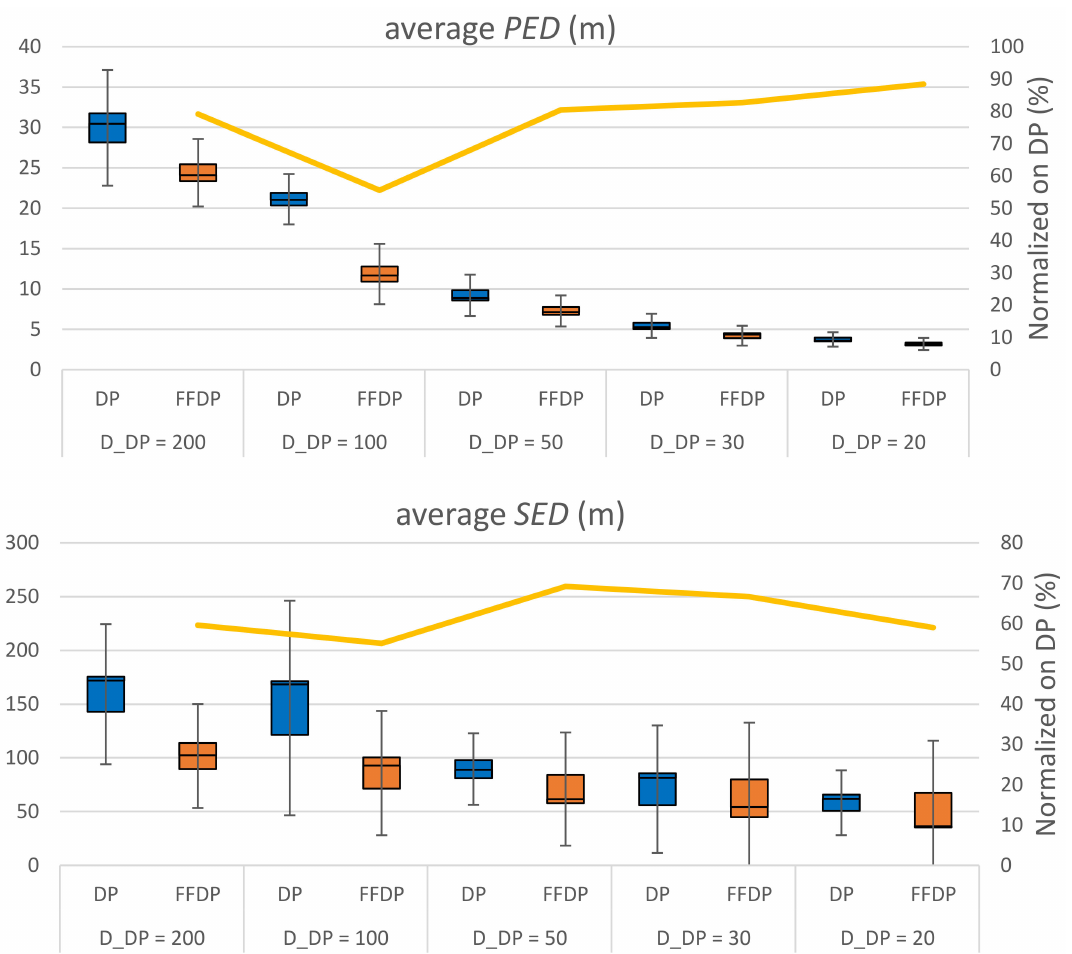
Figure 9. Performance comparison of DP and first-fix (FF)